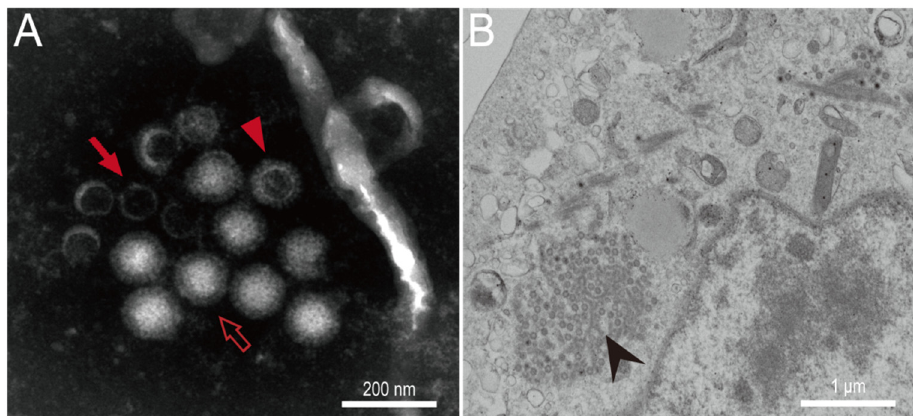
Figure 2. Electron microscopy of BtMRV-QAPpC66. ( A ) Three morphotypes of BtMRV-QAPpC66, i.e., typical virions (open arrow), infectious subvirions (filled triangle) and core particles (filled arrow) can be observed under TEM. ( B ) Ultrathin section of the infected PK-15 cell shows arrayed virions (arrowed) in cytoplasm.